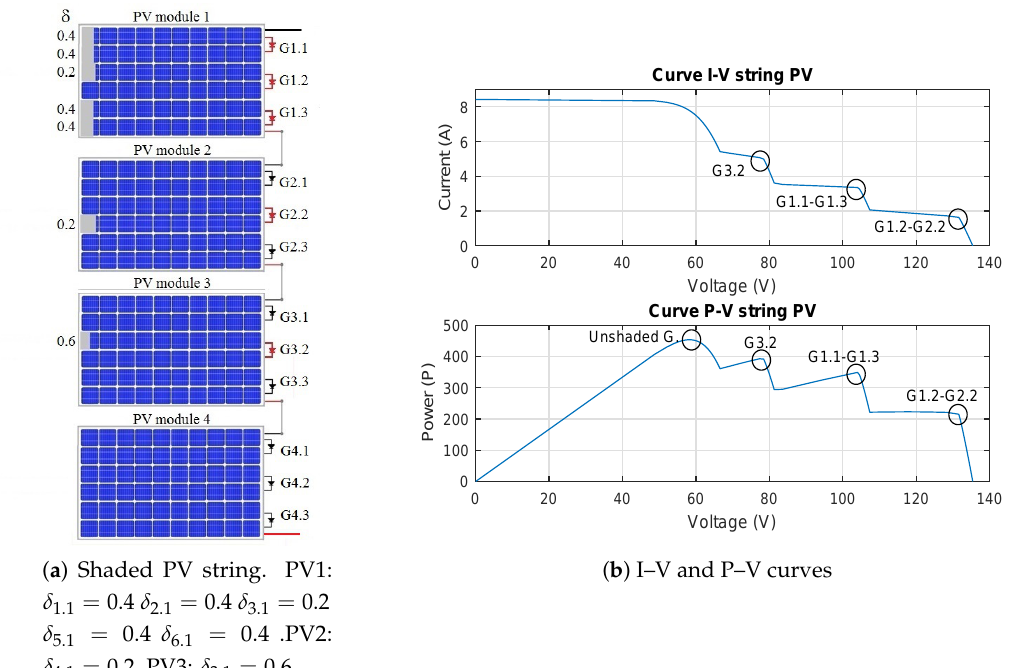
Figure 13. I–V and P–V curves of a shaded PV string.